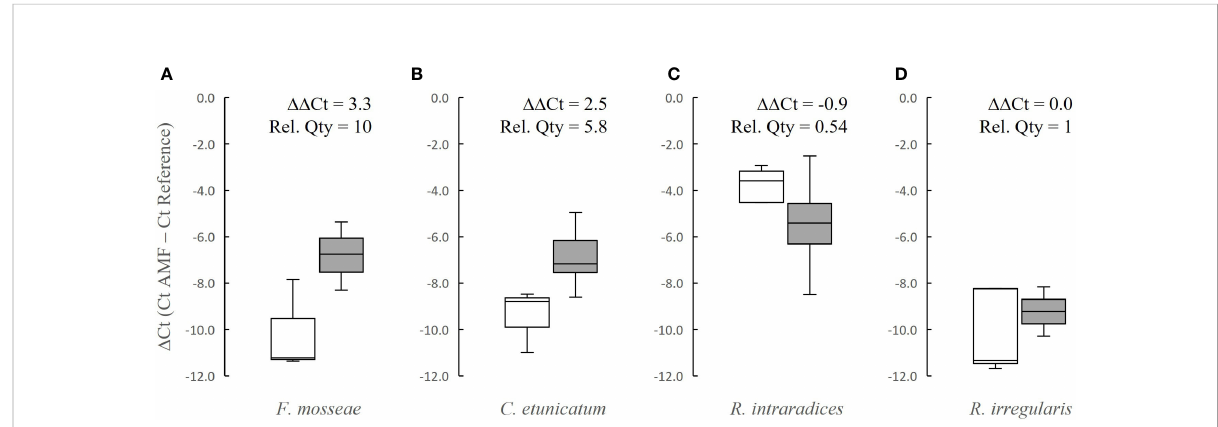
FIGURE 2 Box and whisker plots showing relative quanti fi cation of AMF DNA associated with inoculated corn seedling roots after 15 days (white bars) and 30 days (gray bars) for (A) F. mosseae , (B) C. etunicatum , (C) R. intraradices , and (D) R. irregularis . The difference between the average D Ct value on days 30 and 15 ( DD Ct) was used to calculate the relative quantity (Rel. Qty) for each fungal DNA